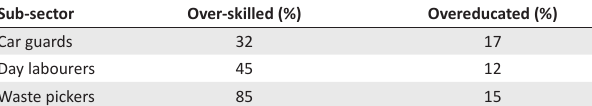
TABLE 2: Type of skills-related underemployment. 3